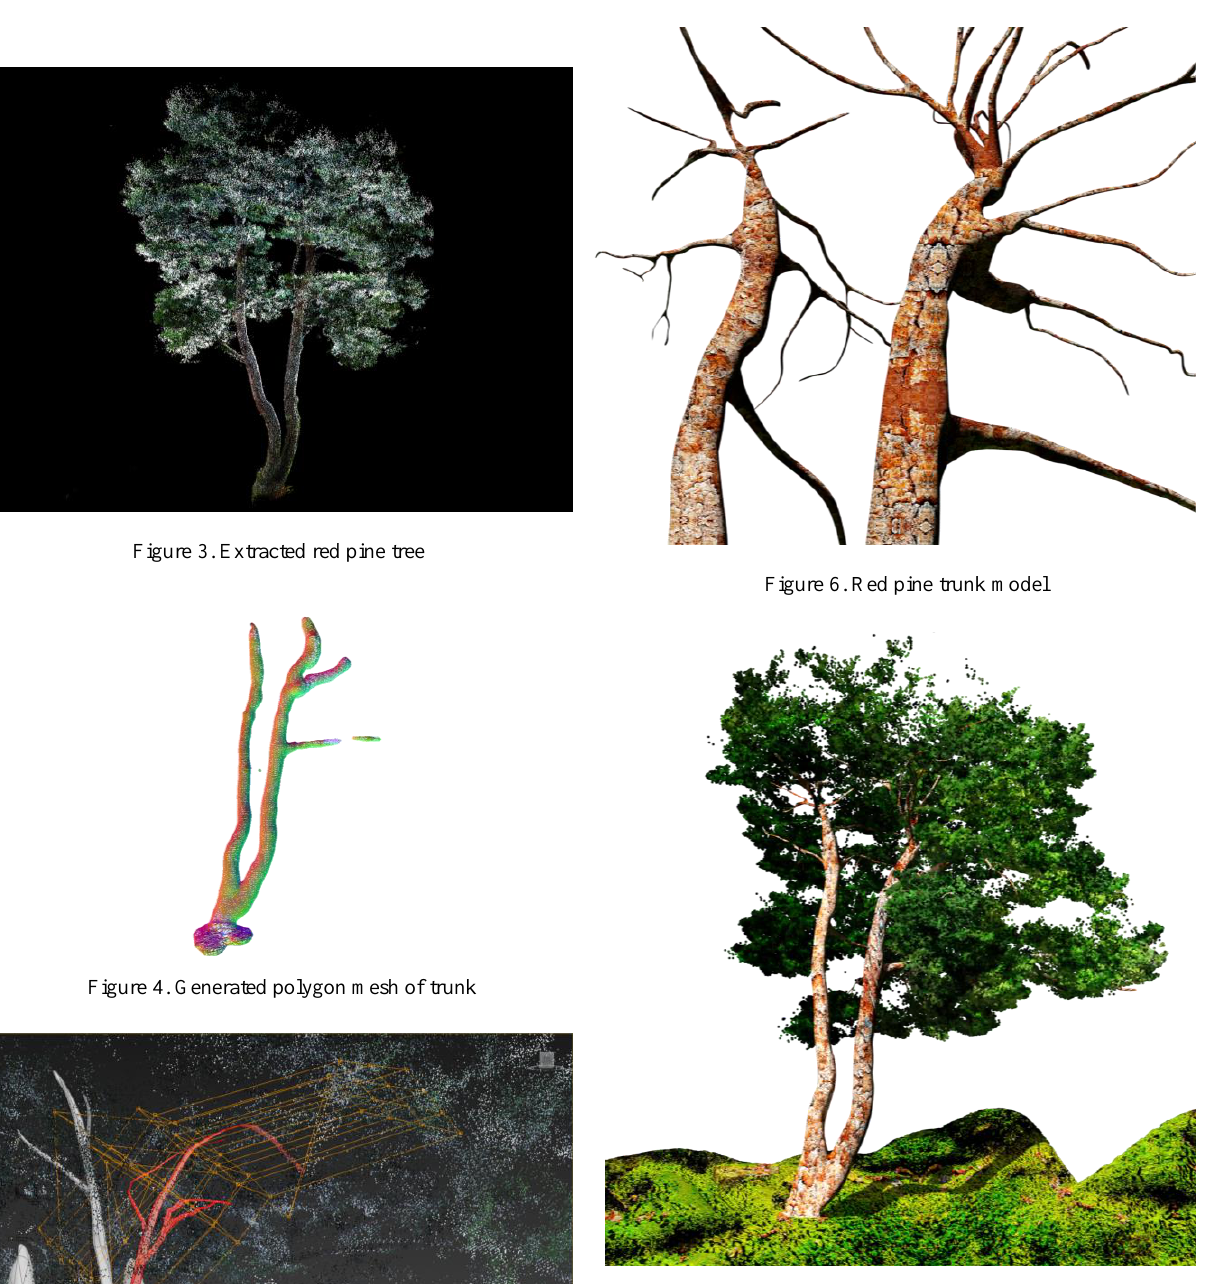
Figure 7. Successful Red Pine